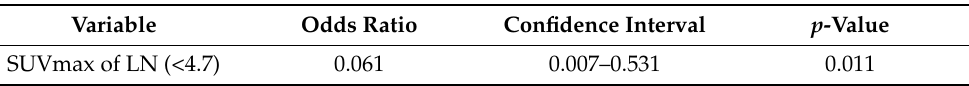
Table 7. Multivariate analysis for factors associated with false positives in integrated 18F-FDG- PET/CT positive